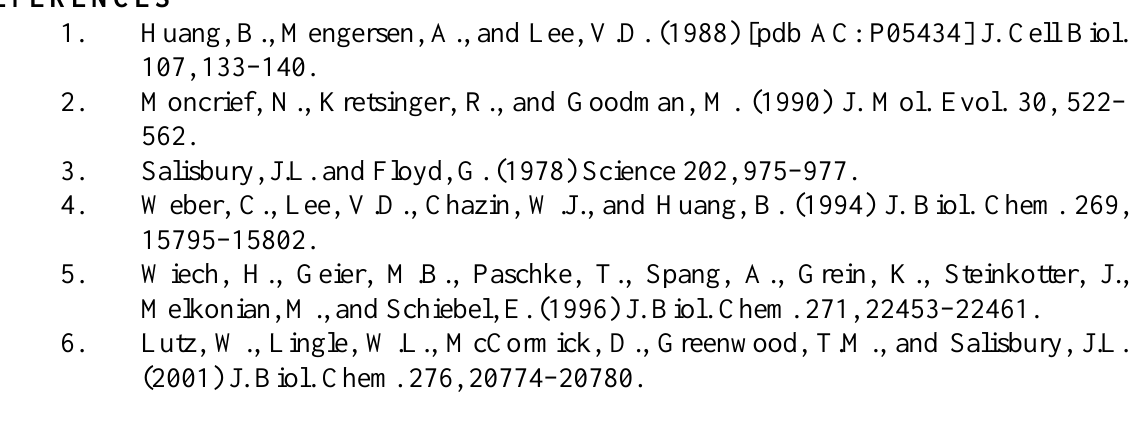
FIGURE 2. Superimposed spectra of the three forms of Ccen; (blue) apo-centrin, (red) holo- centrin, (gold) phosphorylated